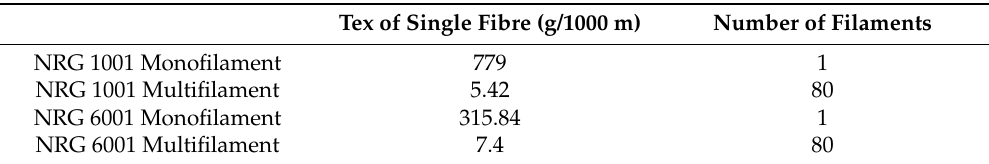
Table 2. Fibre fineness of Vestamid fibres.